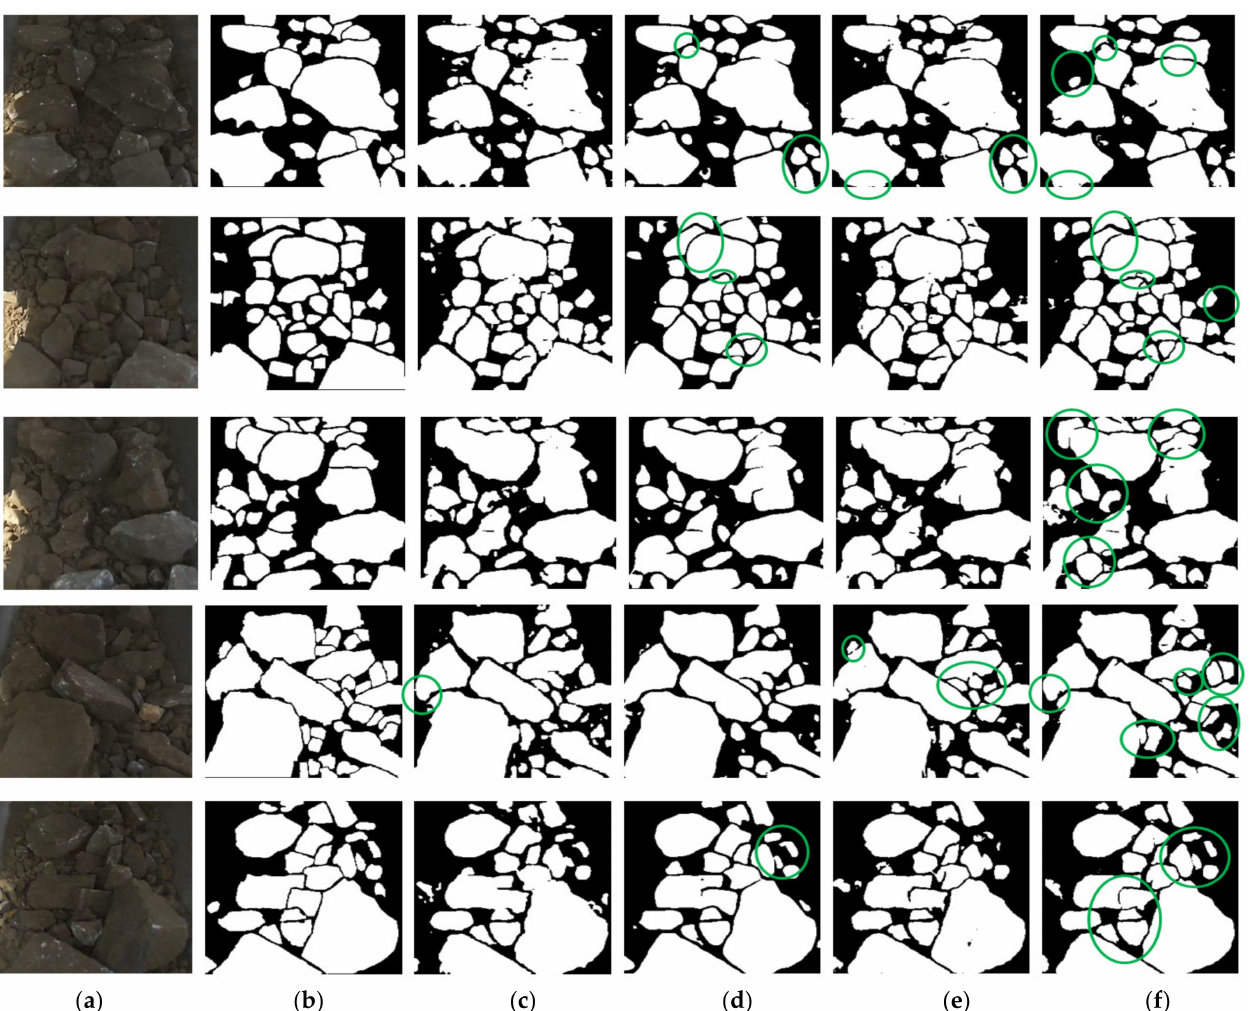
Figure 11. Prediction of different models: ( a ) the raw images; ( b ) the ground truth; ( c ) the results of FCN8; ( d ) the results of PSP; ( e ) the results of U-Net; and ( f ) the results of our